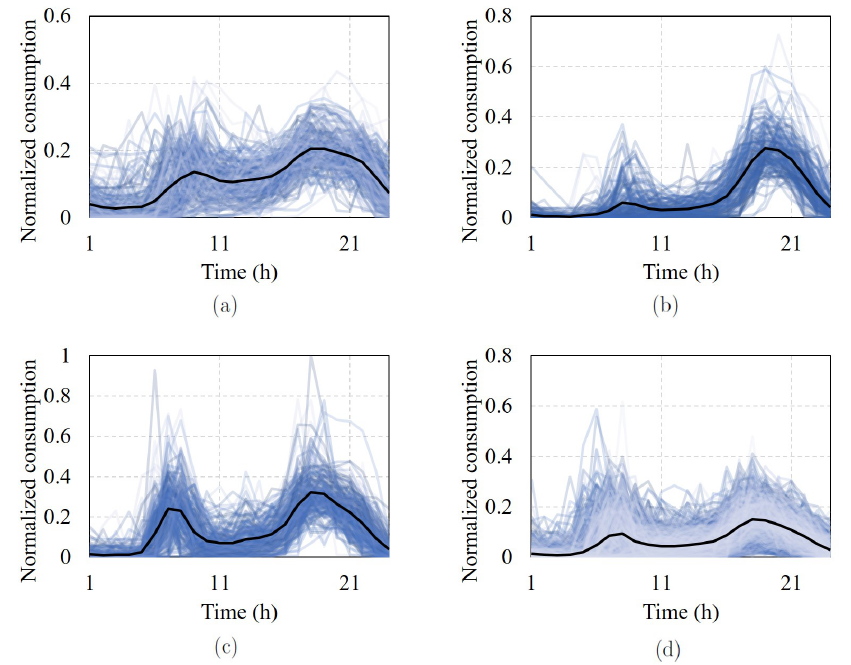
Figure 11. Autumn profiles for four clusters using HC: ( a ) Cluster 1; ( b ) Cluster 2; ( c ) Cluster 3; ( d ) Cluster 4.